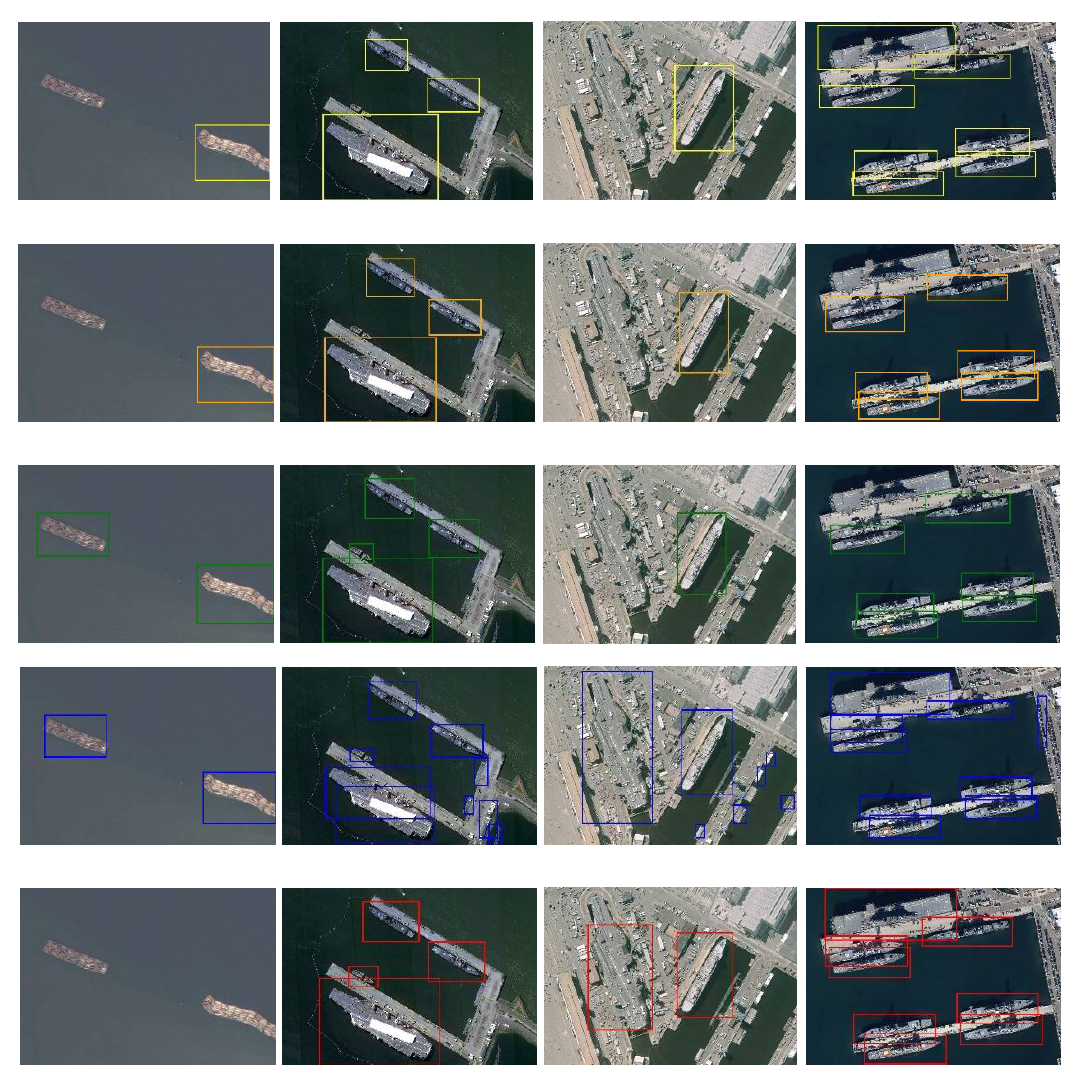
Figure 9. Comparison of test results of different methods. From top to bottom rows are YOLOv3, Retinanet, EfficientDet, Faster R-CNN and SDGH-Net.